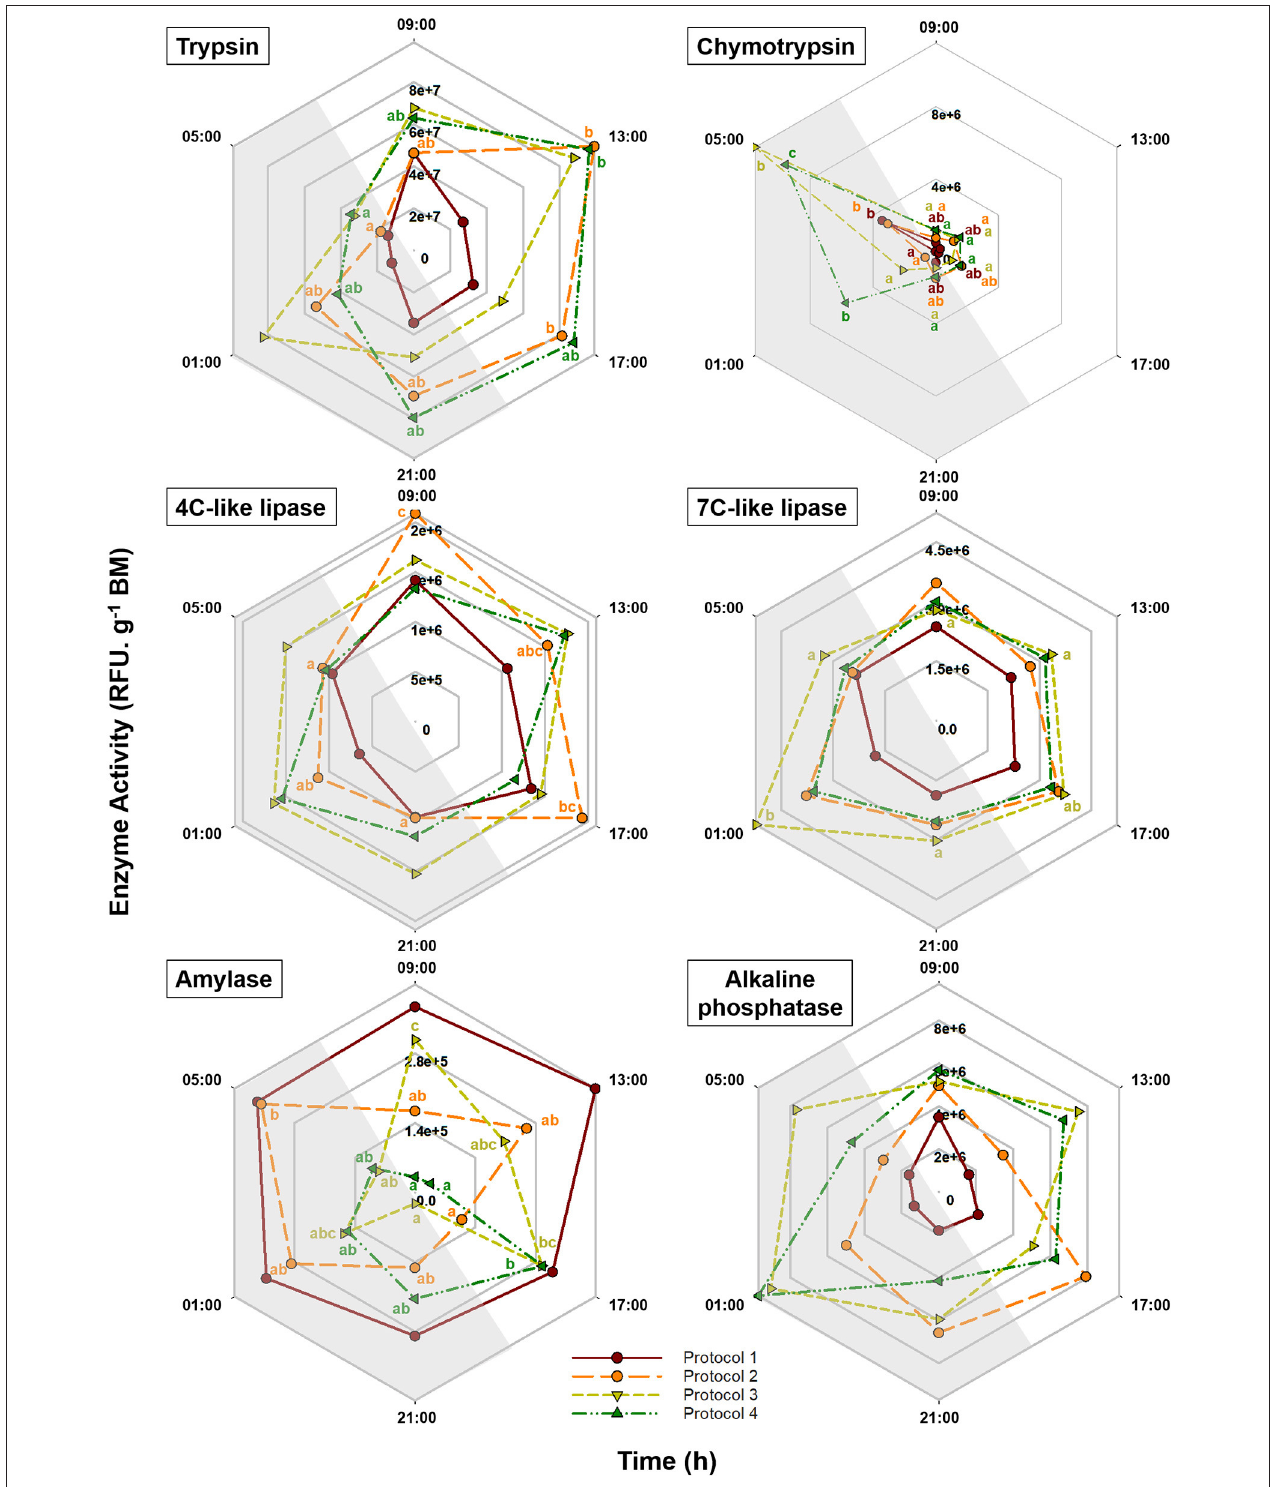
FIGURE 5 | Daily patterns of trypsin, chymotrypsin, amylase, 4C-like lipase, 7C-like lipase, and alkaline phosphatase activity in S. senegalensis with different feeding protocols. Within each protocol, different letters denote significant differences among sampling times (one-way ANOVA, Tukey’s test, p < 0.05). For each feeding protocol, N = 6 individuals per sampling point. Gray areas indicate the dark period.